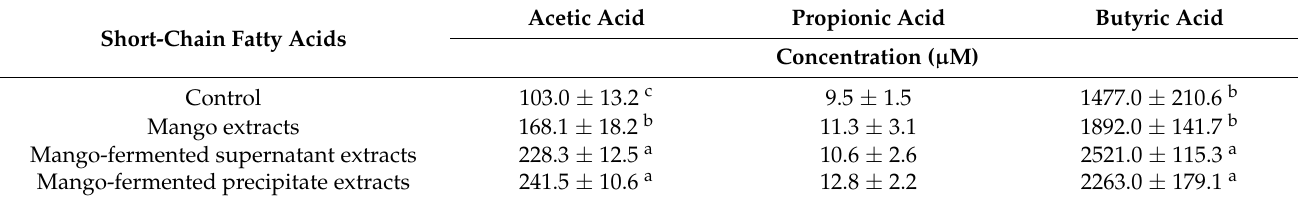
Table 1. The production of short-chain fatty acid production in F. prausnitzii treated with L. acidophilus BCRC14079- fermented